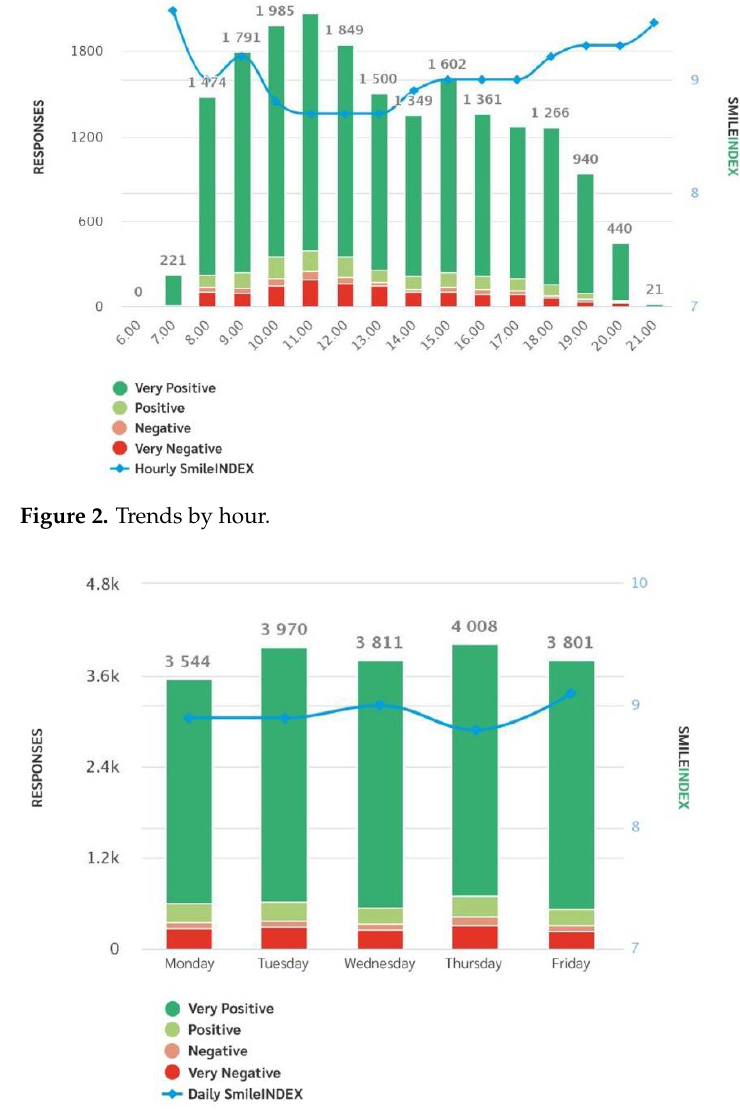
Figure 3. Trends by